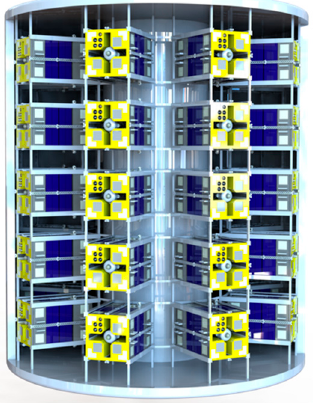
Figure 1. Perspective plot of the orbiter.